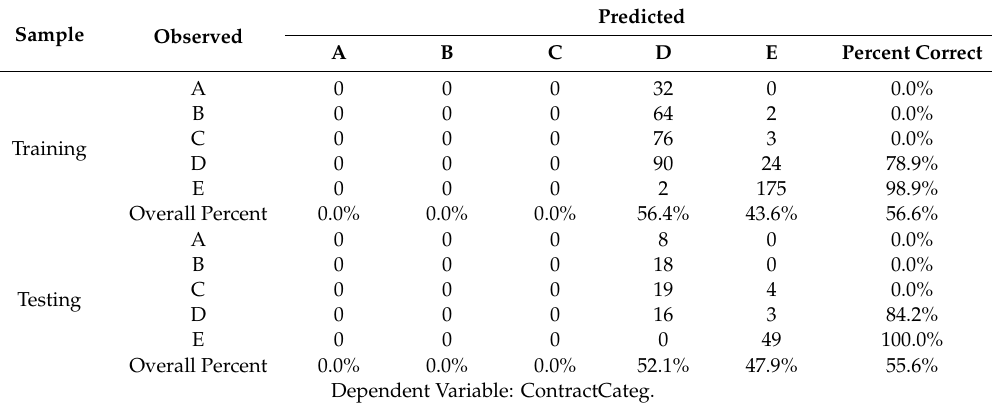
Table 4. Classification of ContractCateg variable.